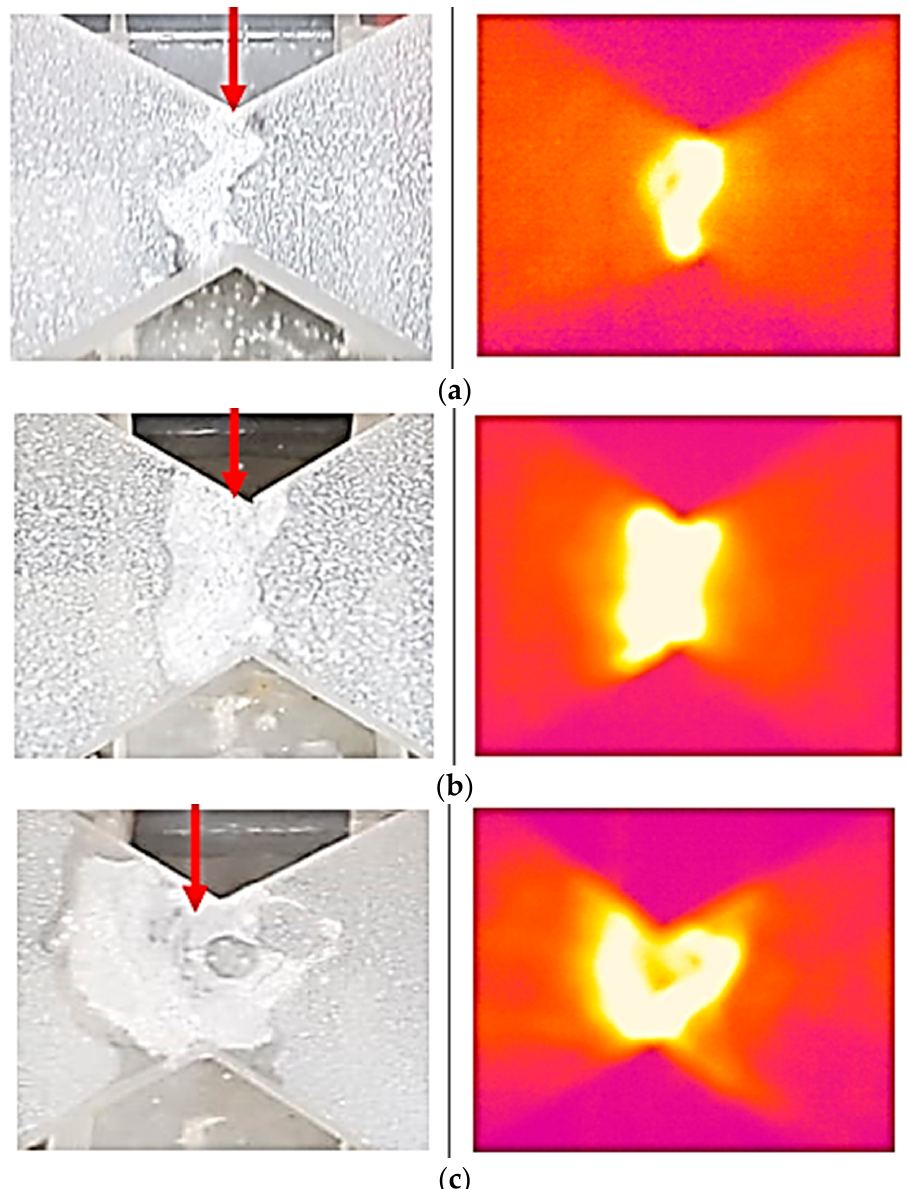
Figure 14. Examples of temperature distribution obtained with the IR camera in the zone of dry band formation (marked with red arrow) for applied voltages of ( a ) 2 kV, ( b ) 4 kV and ( c ) 6 kV for an average ESDD of 1.34 mg/cm 2 .